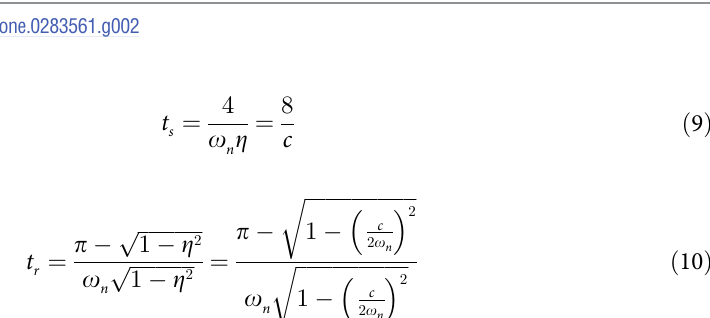
p ffiffiffiffiffiffiffiffiffiffiffiffiffi 1 (cid:0) Z 2 ffiffiffiffiffiffiffiffiffiffiffiffiffi p o 1 (cid:0) Z 2 n